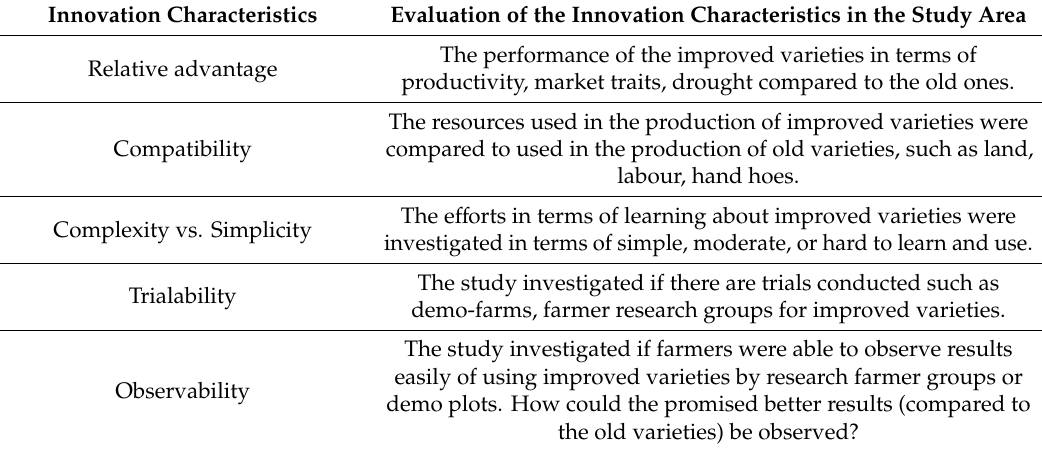
Table 1. Innovation characteristics against the improved groundnut varieties in a study area